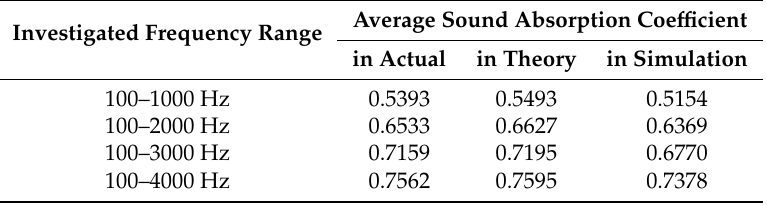
Table 2. Average sound absorption coe ffi cients of the composite sound-absorbing structures.